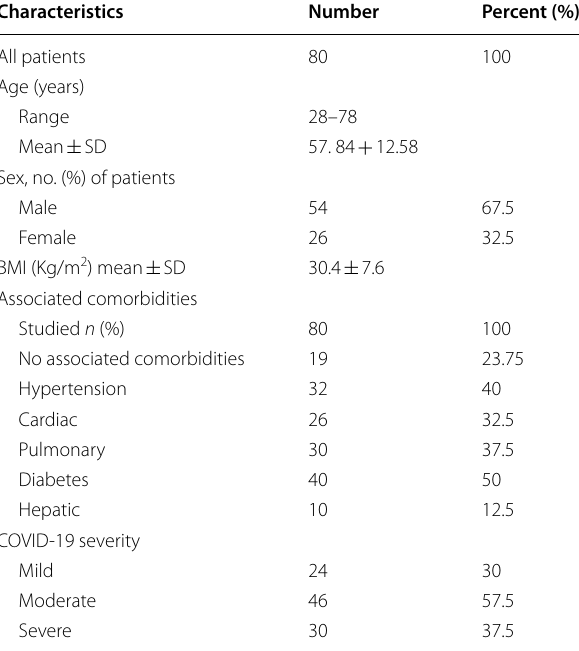
Table 1 Demographic and associated comorbidities in